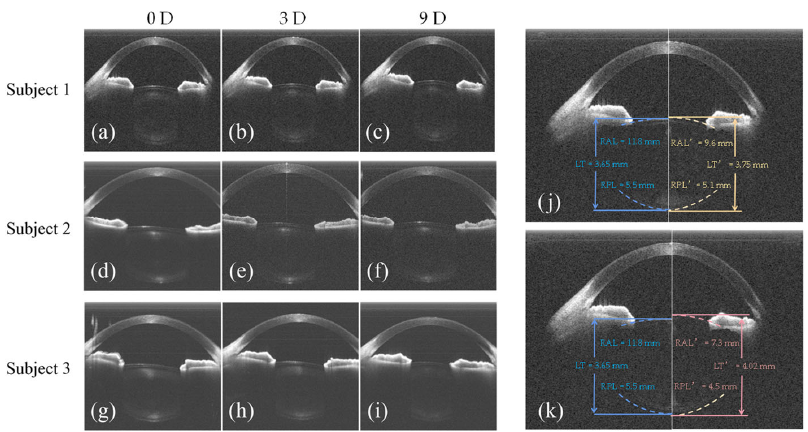
Figure 7. Comparison of anterior segment images obtained by SS-OCT. ( a – i ) the anterior segment images of three subjects under the accommodation stimulus of 0 D, 3 D, and 9 D, respectively. ( j ) and ( k ) the comparisons in different accommodation states of a subject. The left side of the two sub-images is both 0 D stimulus, and the right side is 3 D and 9 D stimulus, respectively.